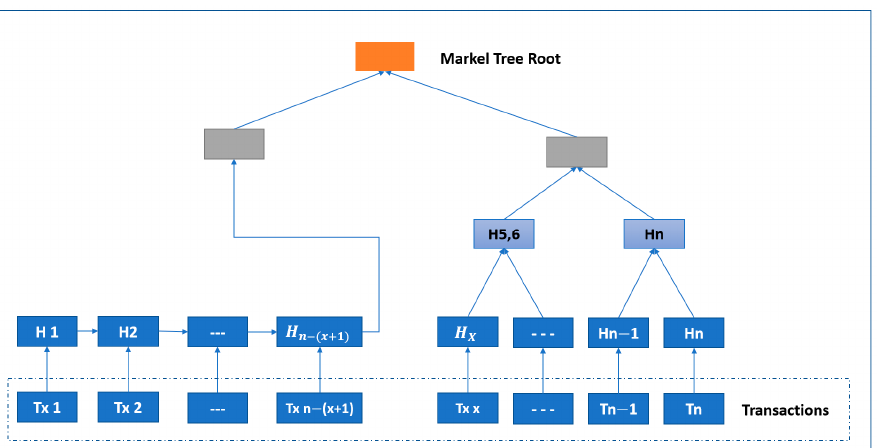
Figure 6. Modified Merkle hash tree (MMHT).